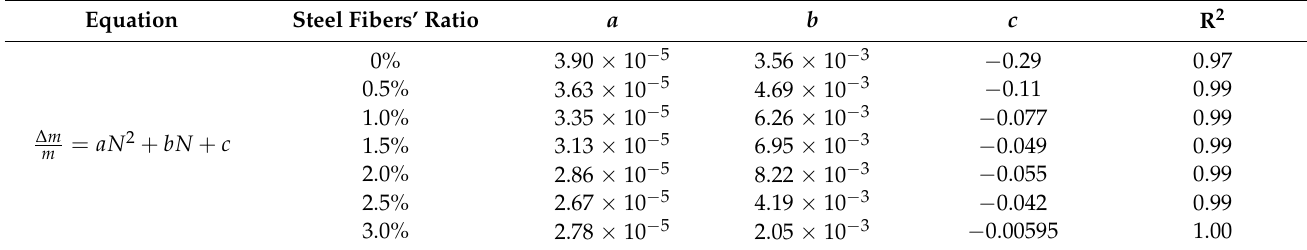
Figure 10. The mass loss rate of reinforced MPC-RPC during NaCl F-T cycles. Table 5. The fitting results of the relationship between ( ∆ m / m ) and the N .